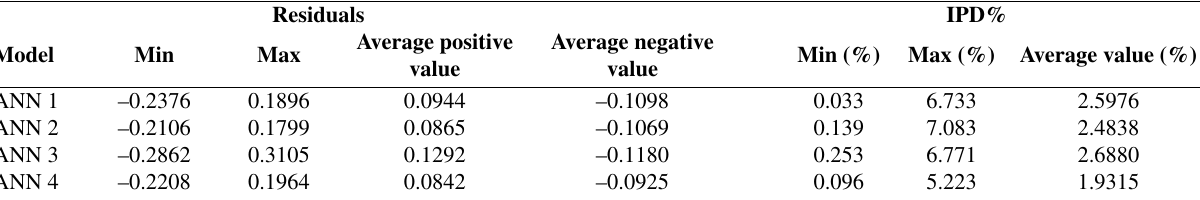
Table 5. Maximum and minimum residual values and IPD% values for ANN models. Residuals